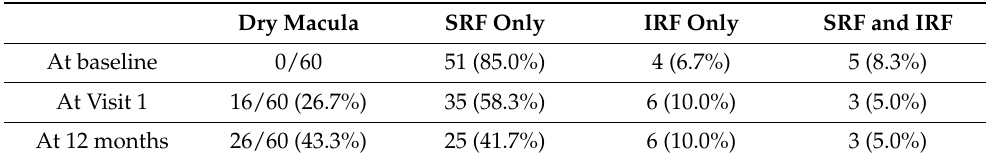
Table 2. Number of the patients with or without exudative change before and after switching to intravitreal injection of brolucizumab.